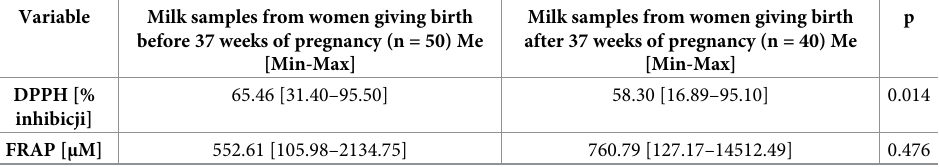
Table 3. Results of the total antioxidant status of breast milk samples in the study groups.